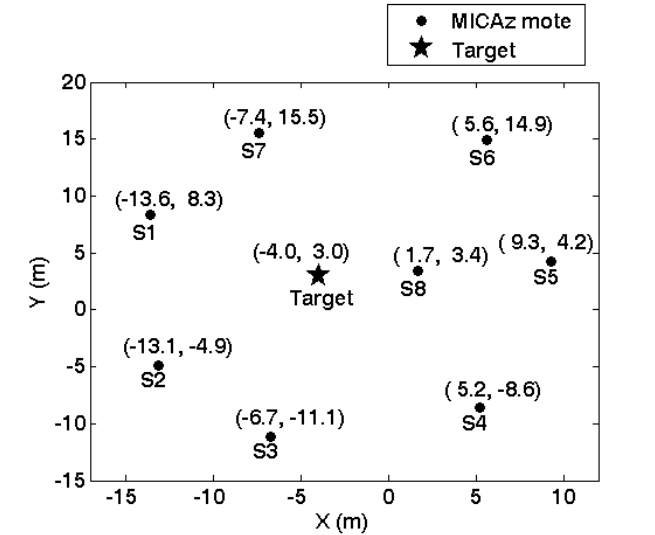
Figure 10. Deployment of MICAz motes on the schoolyard for vehicle localization and